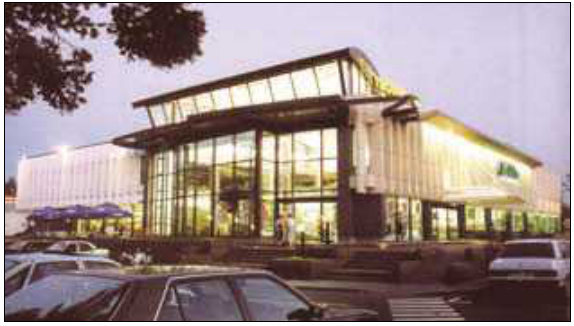
13 pav. Žir­mūnų pr­ekybos centr­as Vilniu­je po r­ekonstr­u­kci- jos (ar­chit. L. Mer­kinas) Fig. 13. Žir­mūnai shopping center­ after­ r­econstr­u­ction in Vilniu­s. a­r­chitect L. Mer­kinas